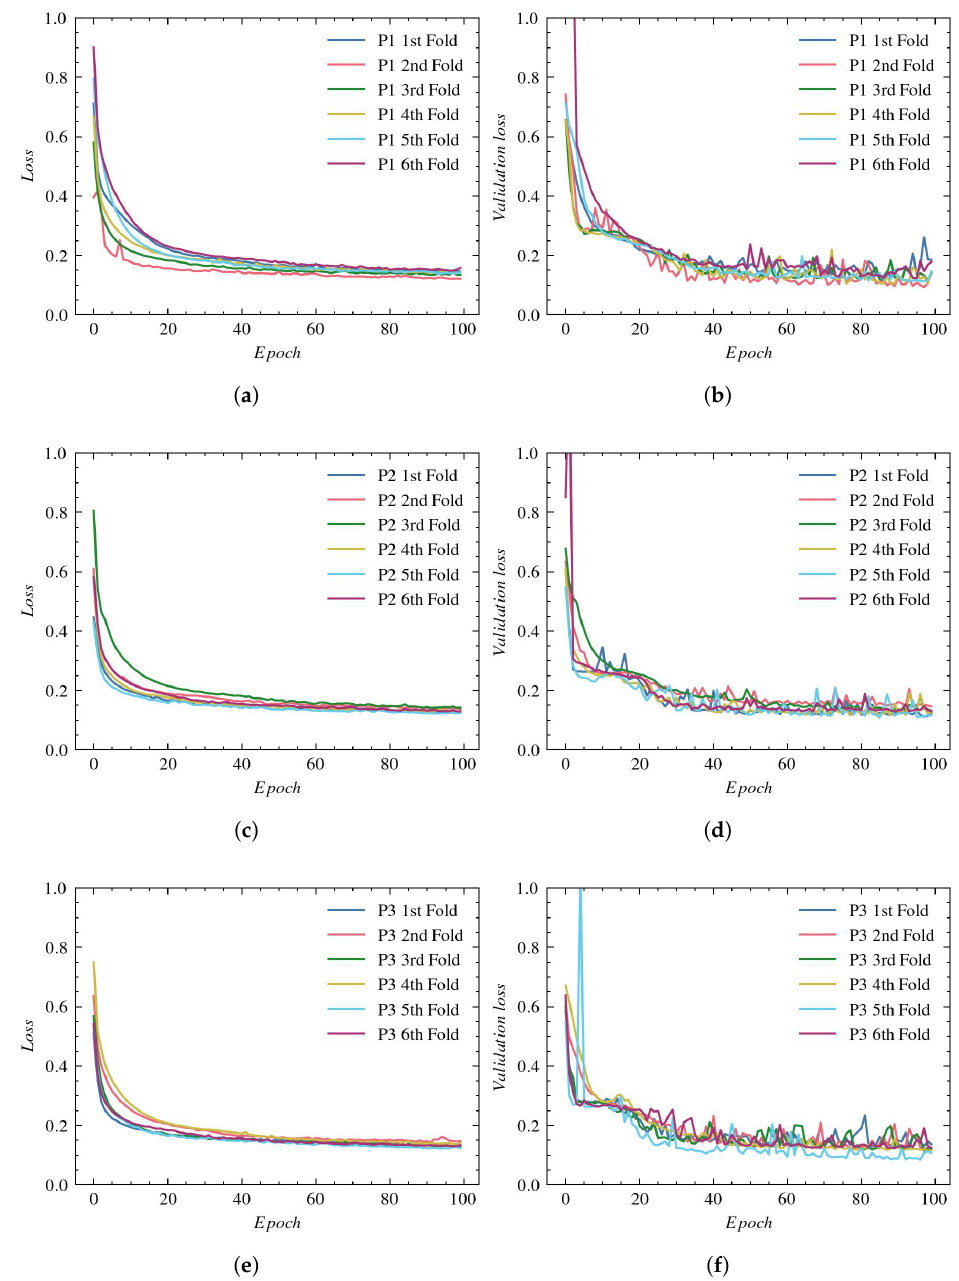
Figure 11. Loss plots for SA-UNet architecture: ( a ) training using P1, ( b ) validation using P1, ( c ) training using P2, ( d ) validation using P2, ( e ) training using P3, and ( f ) validation using P3. The accuracy plots for SA-UNet architecture are presented in Figure 12. The obtained accuracy value for both training and validation is about 96% for all three types of fundus reconstructions. Interestingly, the validation accuracy does not change for the first 15 epochs before increasing from 0.925 to 0.96. This phenomenon was also present in the experiment performed by the authors of the SA-UNet architecture